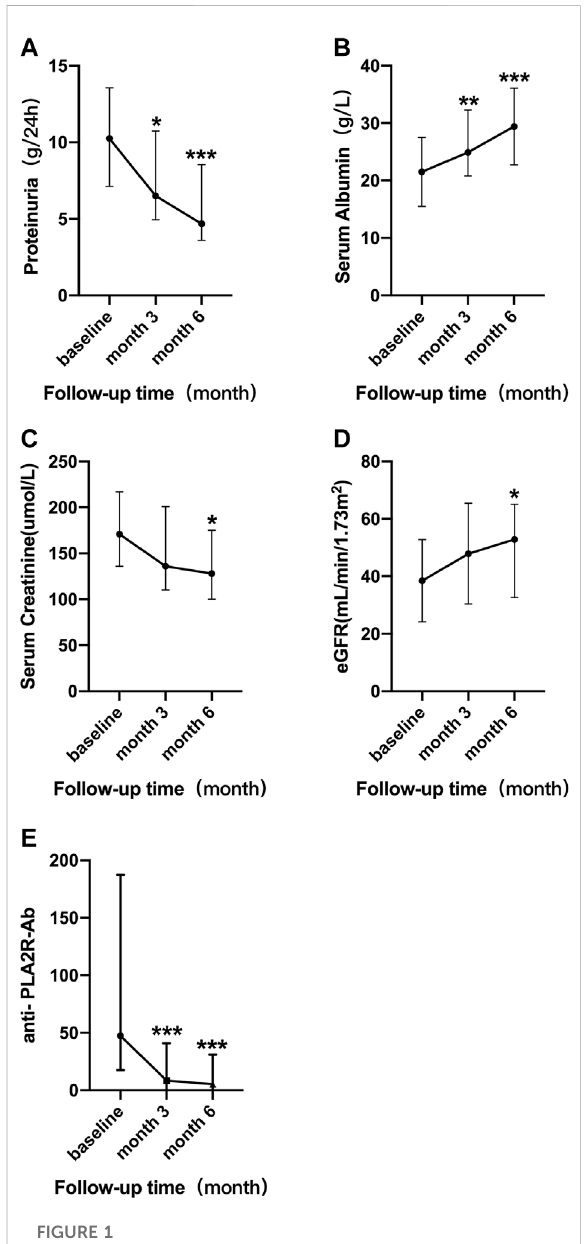
Serial levels of 24 h urinary protein (A) , serum albumin (B) , serum creatinine (C) , eGFR (D) , and anti-PLA2R antibody (E) after the rituximab treatment in all patients who had been followed up for 6 months. The bars show median with interquartile range for each variable. * p < 0.05 vs. baseline; ** p < 0.01 vs. baseline; *** p < 0.001 vs.